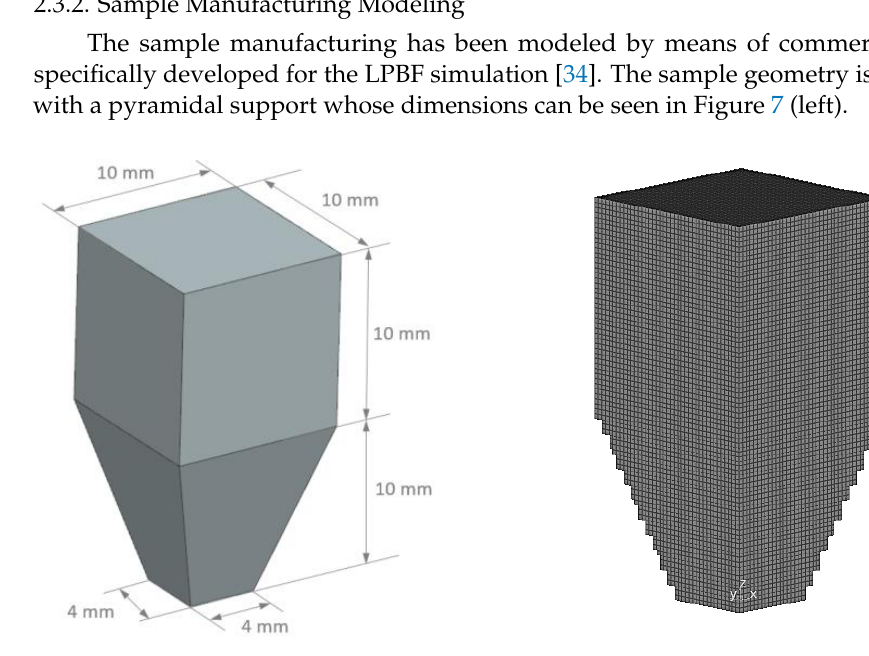
Figure 7. Sample geometry ( left ), mesh ( right ).